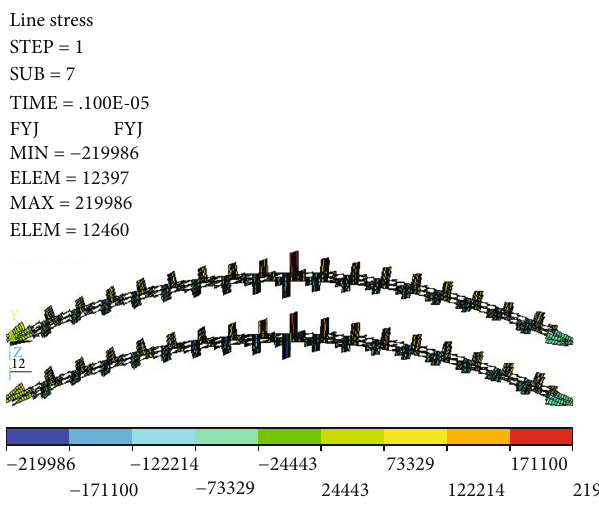
Figure 4: The shear force cloud map of main arch under case 5 (N).